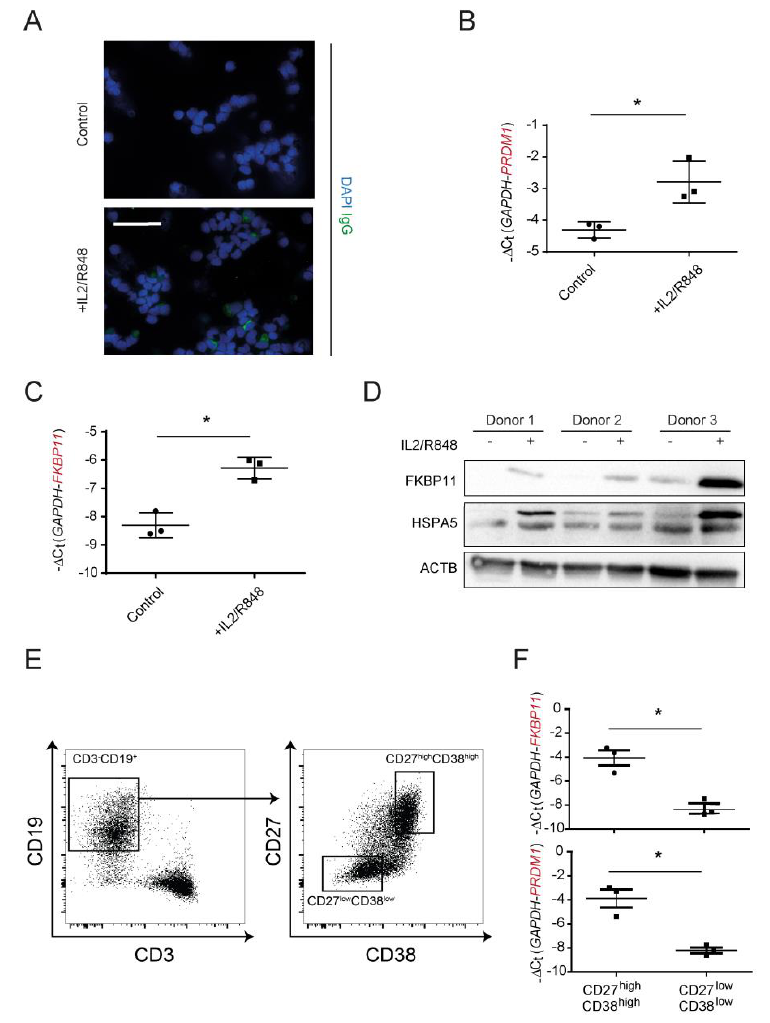
Figure 3. In vitro plasma cell differentiation is accompanied by an increase of FKBP11 expression. PBMCs from blood of three healthy volunteers were treated with interleukin-2 (IL2) and R848 to induce differentiation of memory B cells to antibody-producing plasma cells. ( A ) Increased IgG expression upon treatment was observed using immunofluorescence analysis of cytospins showing cells positive for intracellular IgG. Scale bar 50 µm. ( B ) IL2/R848 treatment led to increased levels of the B cell activation marker PR domain zinc finger protein 1 (PRDM1). ( C , D ) Expression of FKBP11 at transcript ( C ) as well as protein ( D ) level was increased in the course of B cell to plasma cell differentiation. ( D ) Upregulation of the ER chaperone HSPA5 confirmed induction of the unfolded protein response (UPR) during B cell differentiation to plasma cells. ( E ) PBMCs of healthy donors were stimulated for 7 days with IL-2 and R848. Subsequently, the activated and differentiated cells were pre-gated on live and singlet cells and further gated on CD3 - and CD19 + B cells (left panel). Plasmablasts (CD19 + CD27 high CD38 high ) and non-plasmablast B cells (CD19 + CD27 low CD38 low ) were bulk sorted using FACSAria Fusion (right panel). Flow cytometry panels are displayed from one representative donor of three independent experiments. ( F ) Expression of FKBP11 and PRDM1 were analyzed by qPCR of the sorted cell fractions. ACTB = β -actin as loading control. For IgG concentrations and qPCR results, data shown are mean ± SEM, and a paired t-test was used for statistical analysis (* p ≤ 0.05; exact p -values: B: p = 0.0474; C: p = 0.0194; F top panel (FKBP11): p = 0.0180; F bottom panel (PRDM1): p = 0.0495).